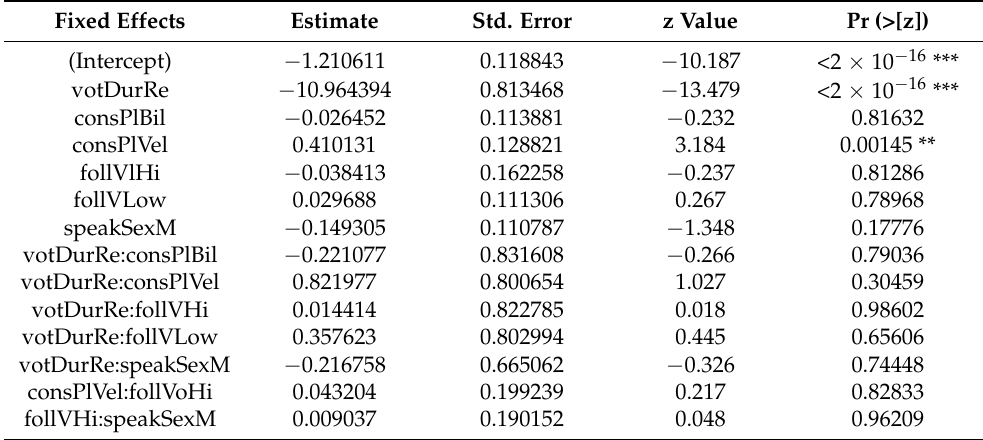
Table A1. Generalized linear mixed model (Experiment 1, original voice tokens).